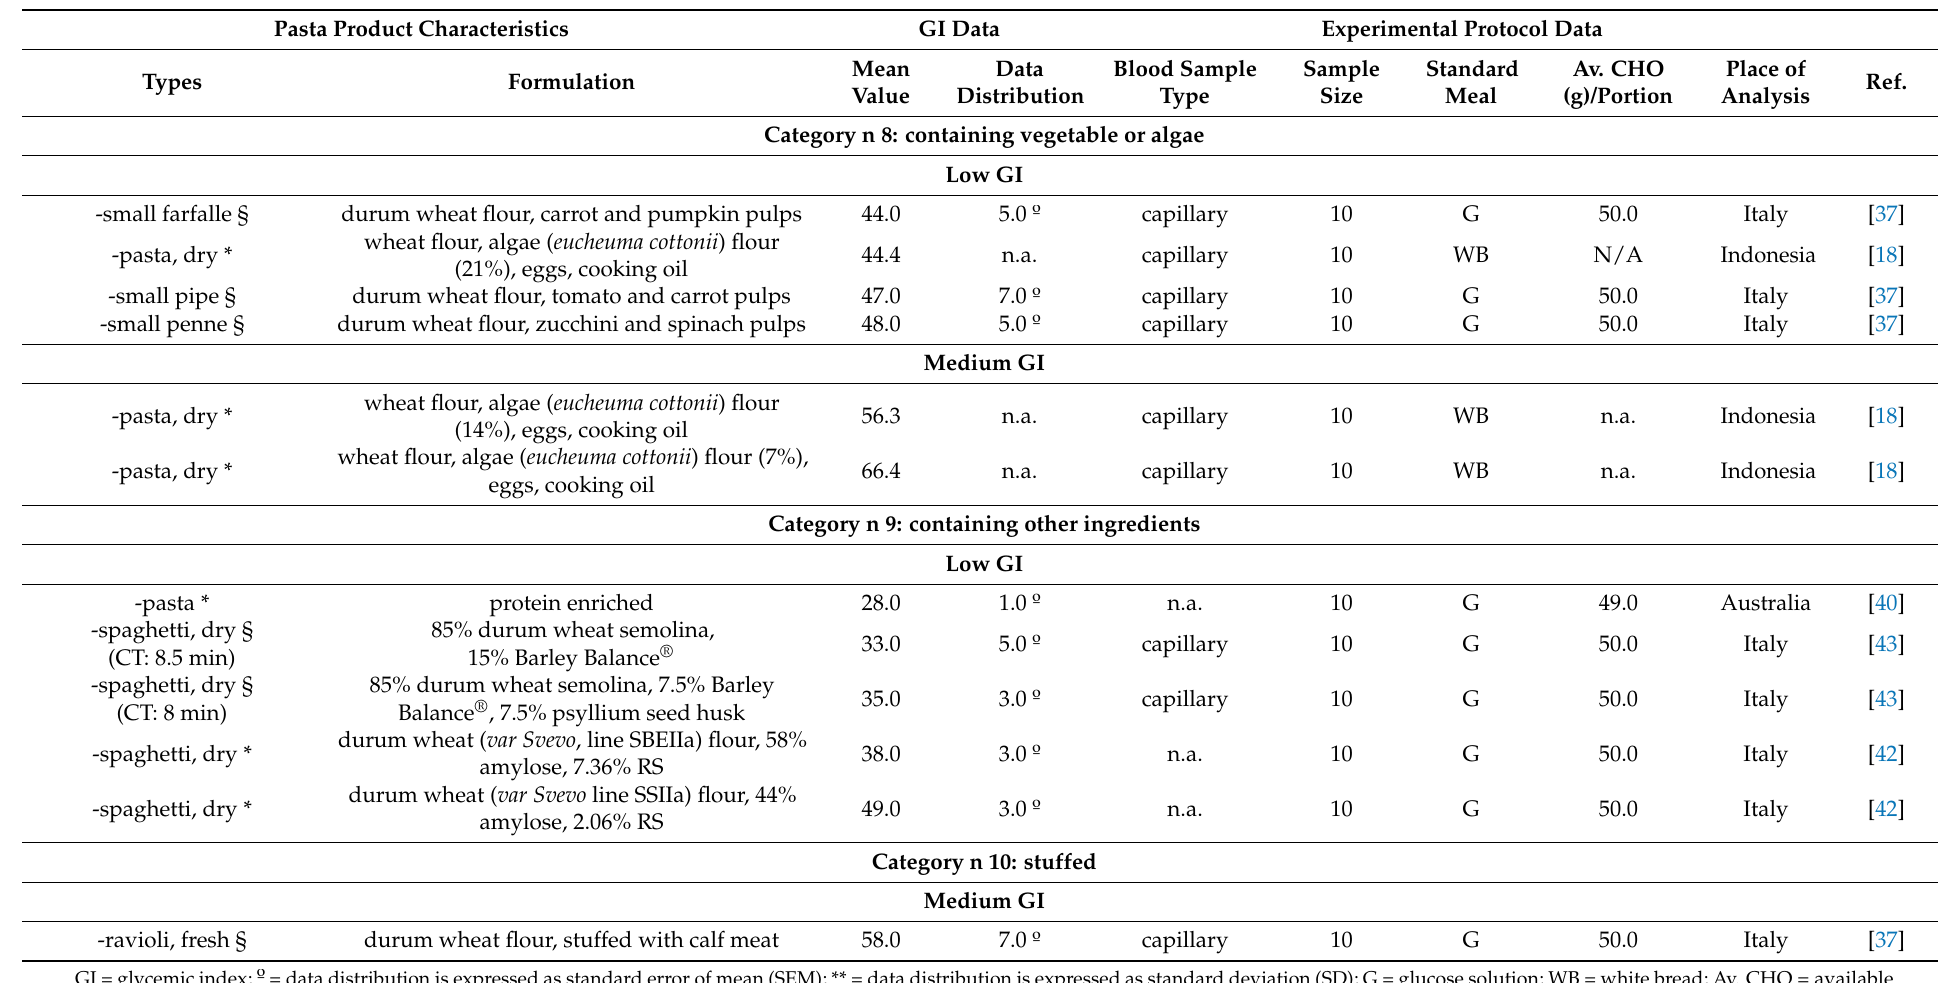
Table 1. Pasta product characteristics, glycemic index and experimental protocol data.